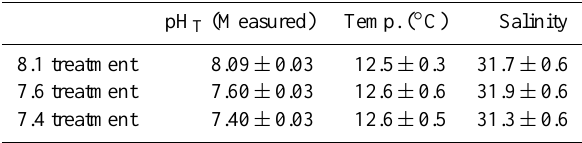
Table 1. Average values ( ± SD, n = 64) for pH T , temperature, and salinity, recorded over a 90-day period in three pH treatment tanks during the culture of Z. subcarinatus